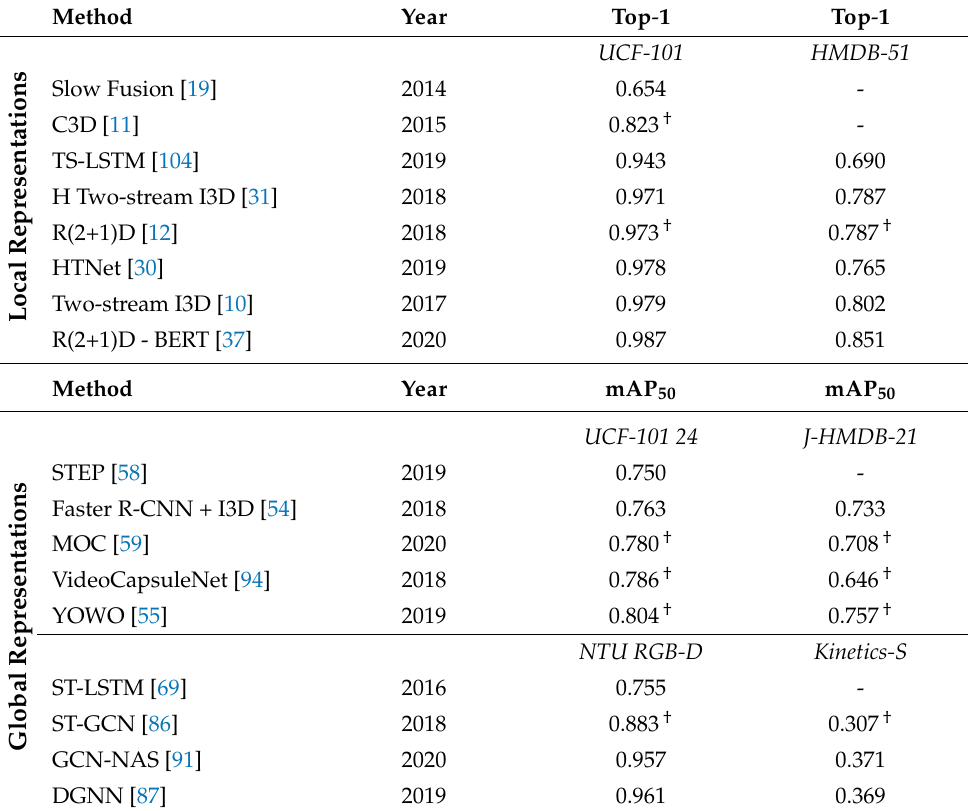
Table 2. Performance summary of some reference action recognition methods from both categories, local and global representation approaches over their respective benchmarks in terms of accuracy and mean average